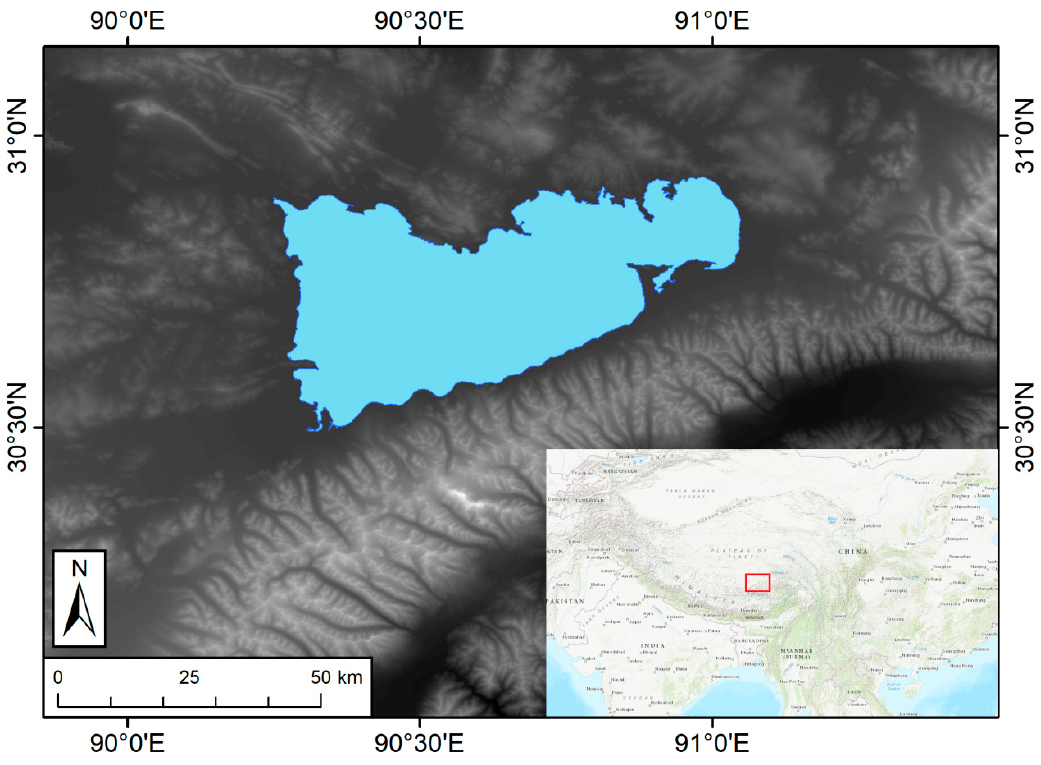
Figure 1. Nam Co lake in Tibet, located in red box in inset lower right image (©ESRI 2018, [7]), shown against TanDEM-X 12 m digital elevation model (DEM) (©DLR 2017). At an elevation of 4726 m and size of 2,000 km 2 , it is both one of the world’s highest lakes and one of the largest on the Tibetan Plateau.